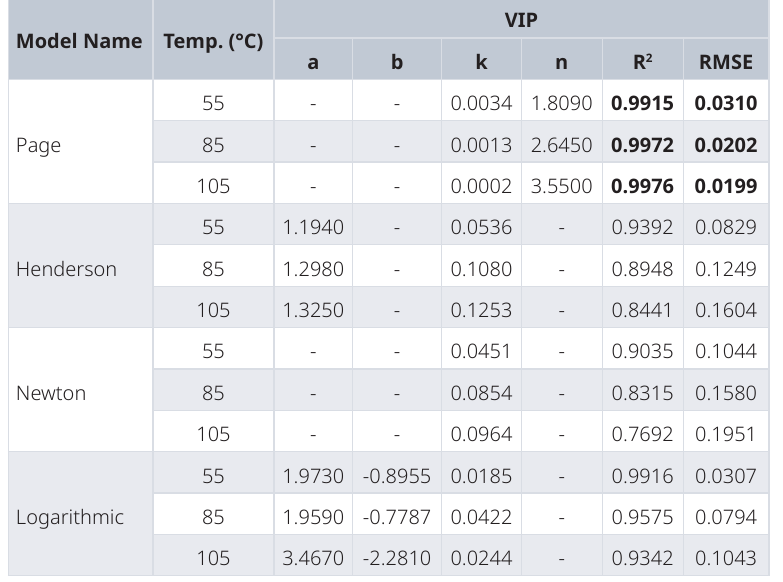
Table 6. Statistical data for isothermal drying of ventilated improved pit